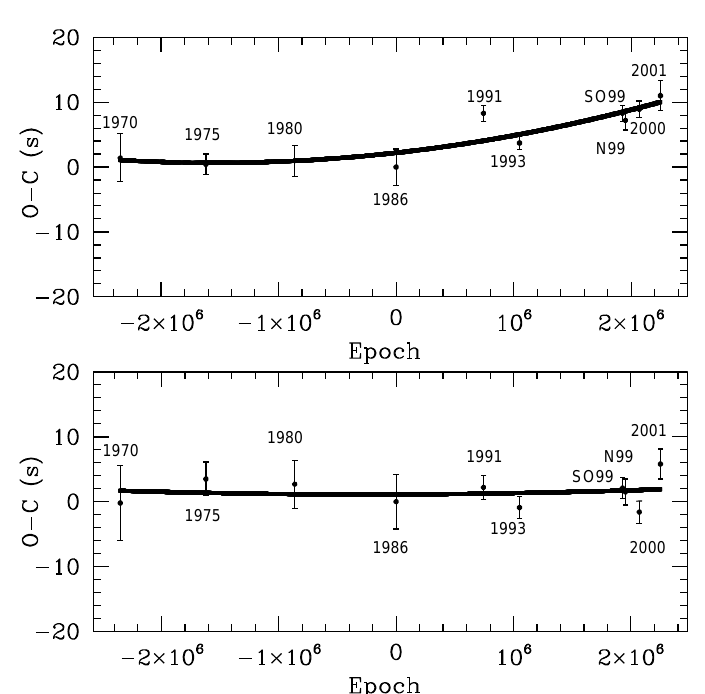
Fig. 4. The top panel shows an ( O – C ) plot for the 213.13260456 s period, with the best fit parabola ˙P =(6.1 ± 3.1) × 10 − 15 s/s drawn as a con- tinuous line. The lower panel indicates an ( O – C ) diagram for the period 212.76842927 s with the best fit of ˙P =(1.2 ± 4.0) × 10 − 15 s/s. (The 1991 data set spans only 5 days, and is our shortest season. Most seasons span over a month and hence their phases are more